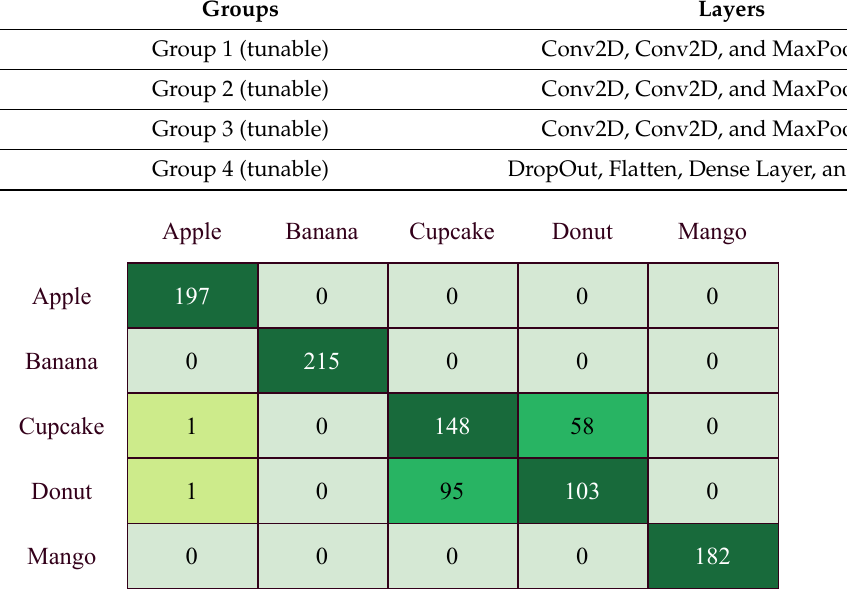
Figure 3. Confusion Matrix of model